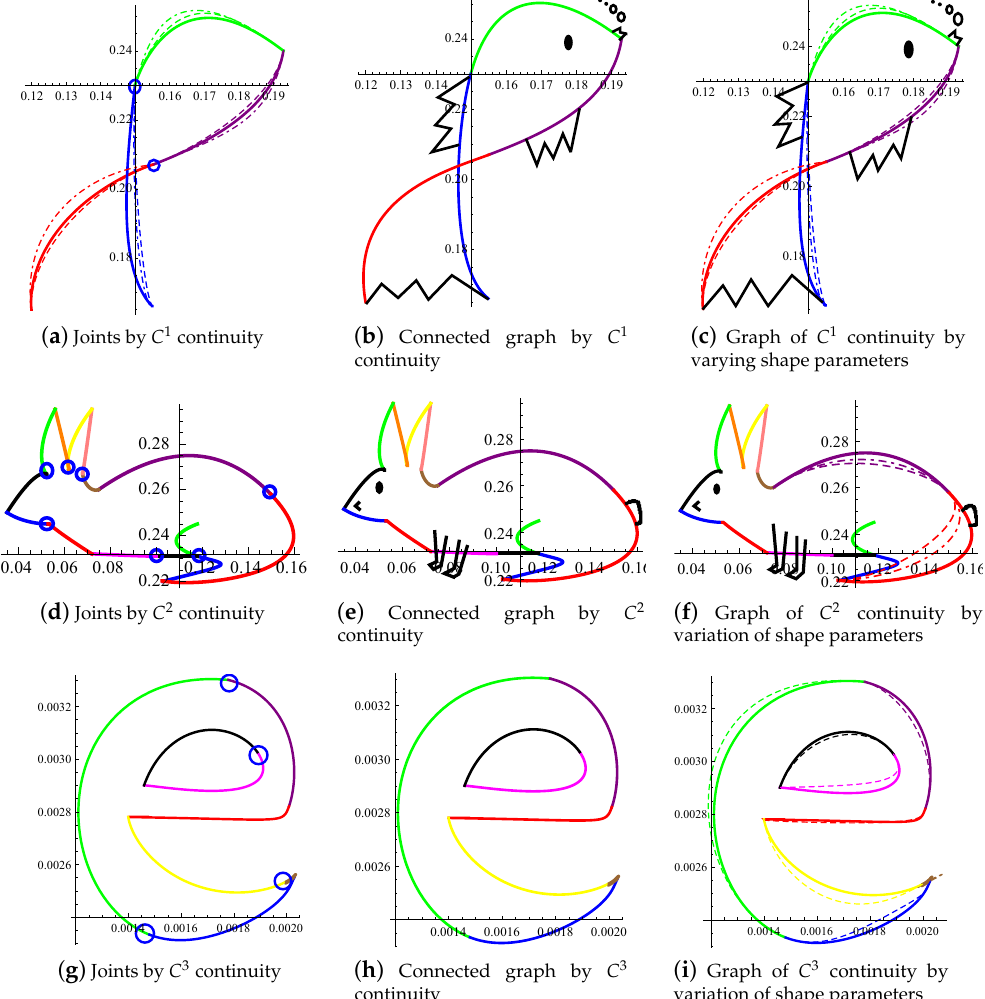
Figure 14. Modeling by the C 1 , C 2 , and C 3 smooth continuity of GHT-Bézier curves by varying shape parameters. ( a ) Joints by C 1 continuity; ( b ) connected graph by C 1 continuity; ( c ) graph of C 1 continuity by varying shape parameters; ( d ) joints by C 2 continuity; ( e ) connected graph by C 2 continuity; ( f ) graph of C 2 continuity by variation of shape parameters; ( g ) joints by C 3 continuity; ( h ) connected graph by C 3 continuity; ( i ) graph of C 3 continuity by variation of shape parameters. Example 10. It is well known that in geometric continuity, the tangents are collinear, and they may not have